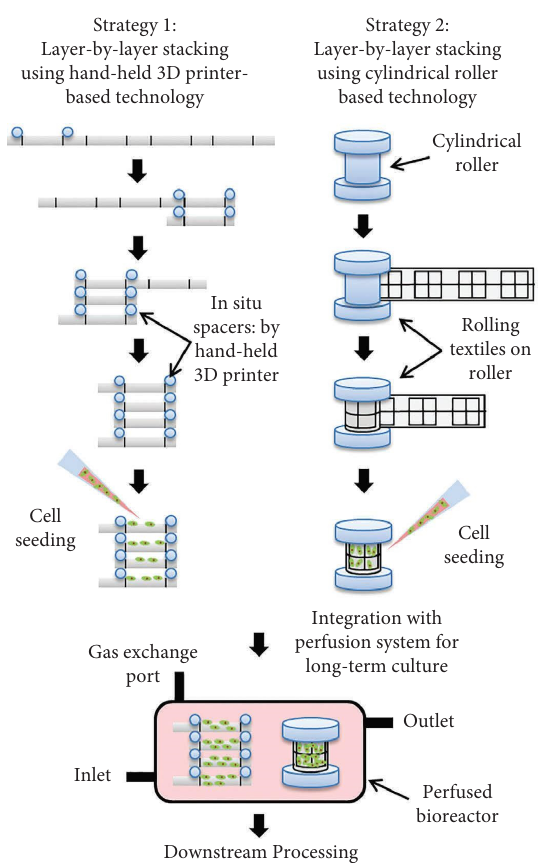
Figure 4: Strategies for large-scale cell culture using textile